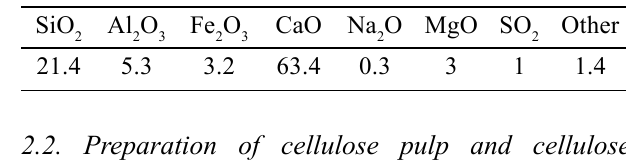
Table 1 . Chemical composition of the cement (%